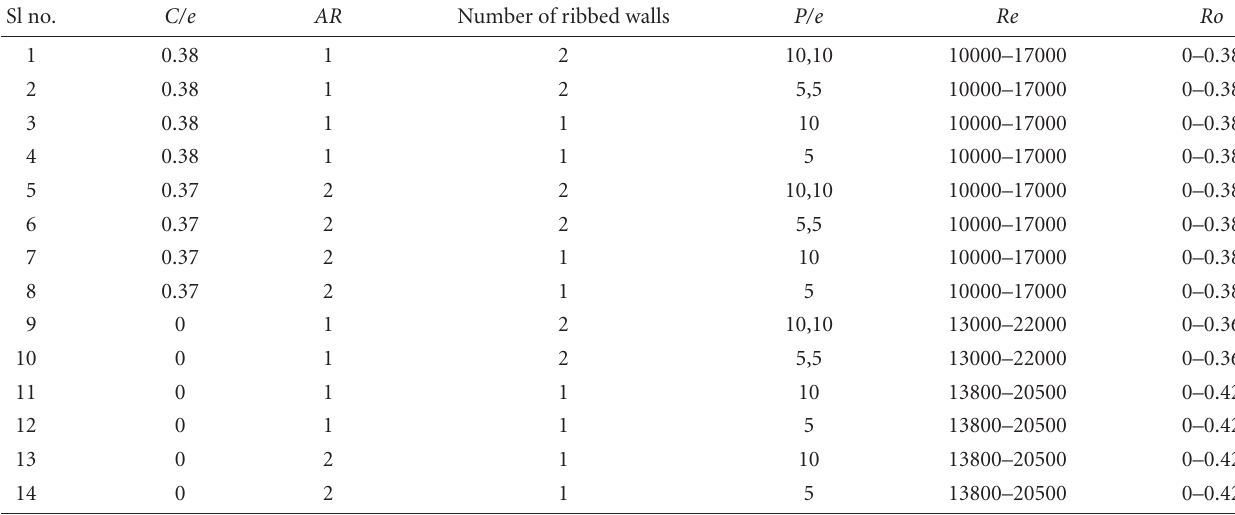
Table 1: Details of detached rib configurations covered in this study and corresponding attached rib configurations available in the literature for comparison.